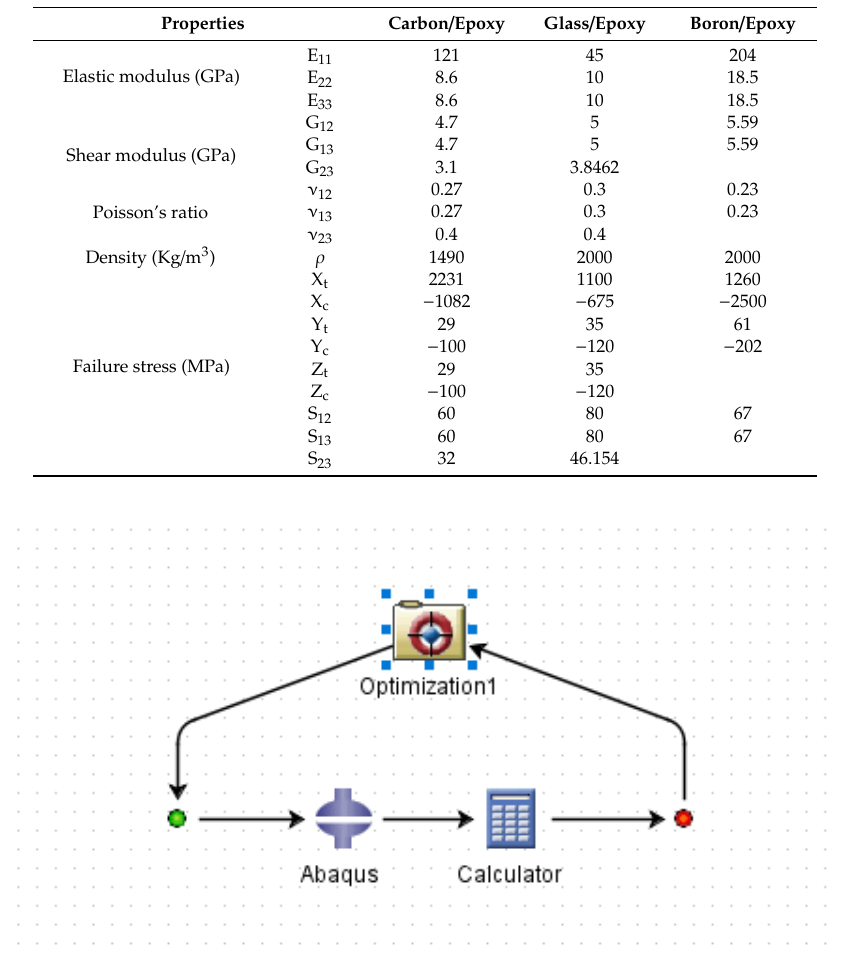
Table 1. Material properties of carbon / epoxy, glass / epoxy, and boron / epoxy [10,55].